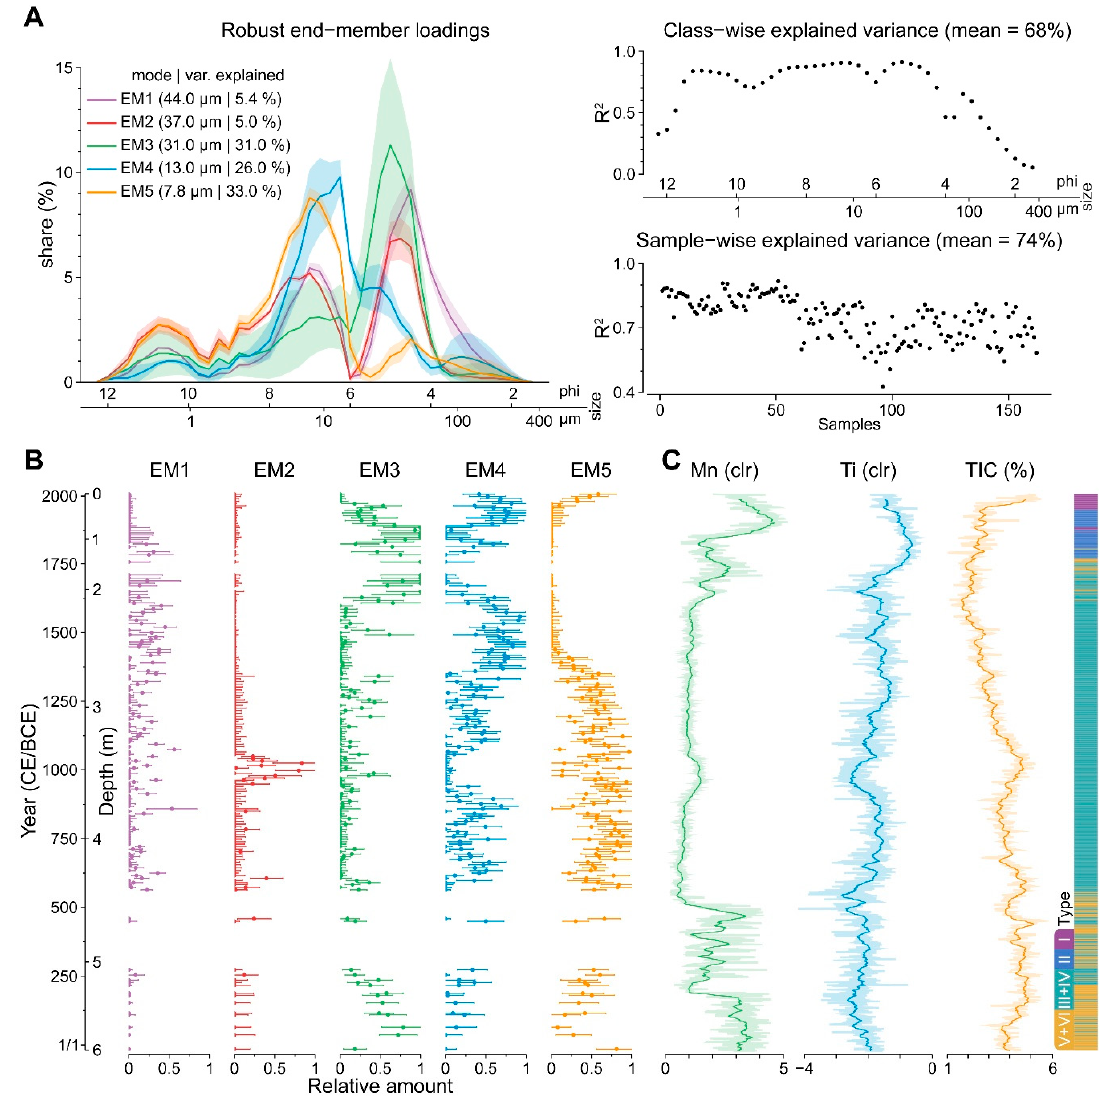
Figure 8. ( a ) End-members loadings with diagnostic plots. ( b ) Relative abundance of end-members vs time and depth. ( c ) Profiles of selected geochemical proxies (µXRF centered log-ratios (clr) of Mn and Ti, TIC—total inorganic carbon) with a 20-year running mean and varve types ( Ż arczy ń ski et